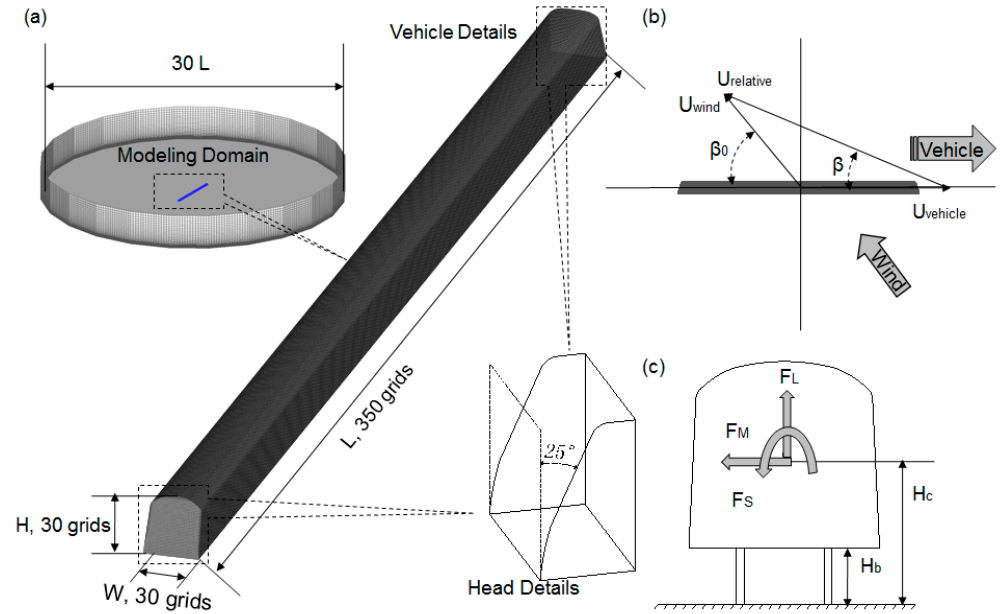
Figure 6. ( a ) Model and mesh details in CFD (Computational Fluid Dynamics) simulation. The whole model domain is a 24-sided prism, with an externally tangent circle diameter of 30 L. The train model with two oblique faces of 25° lies in the center of the model domain, and its horizontal, longitudinal, and vertical lines are meshed with 30, 30, and 350 grids, respectively. ( b ) Relation between vehicle velocity ( U vehicle ), wind velocity ( U wind ), and resultant relative wind velocity ( U relative ) for a train subjected to crosswinds. β is the yaw angle of the relative wind velocity, β 0 the yaw angle of wind velocity. ( c ) Aerodynamic forces reference system: the aerodynamic lift force, F L , lateral (or side) aerodynamic force, F S , and overturning moment, F M . The dimensions refer to X and Y.